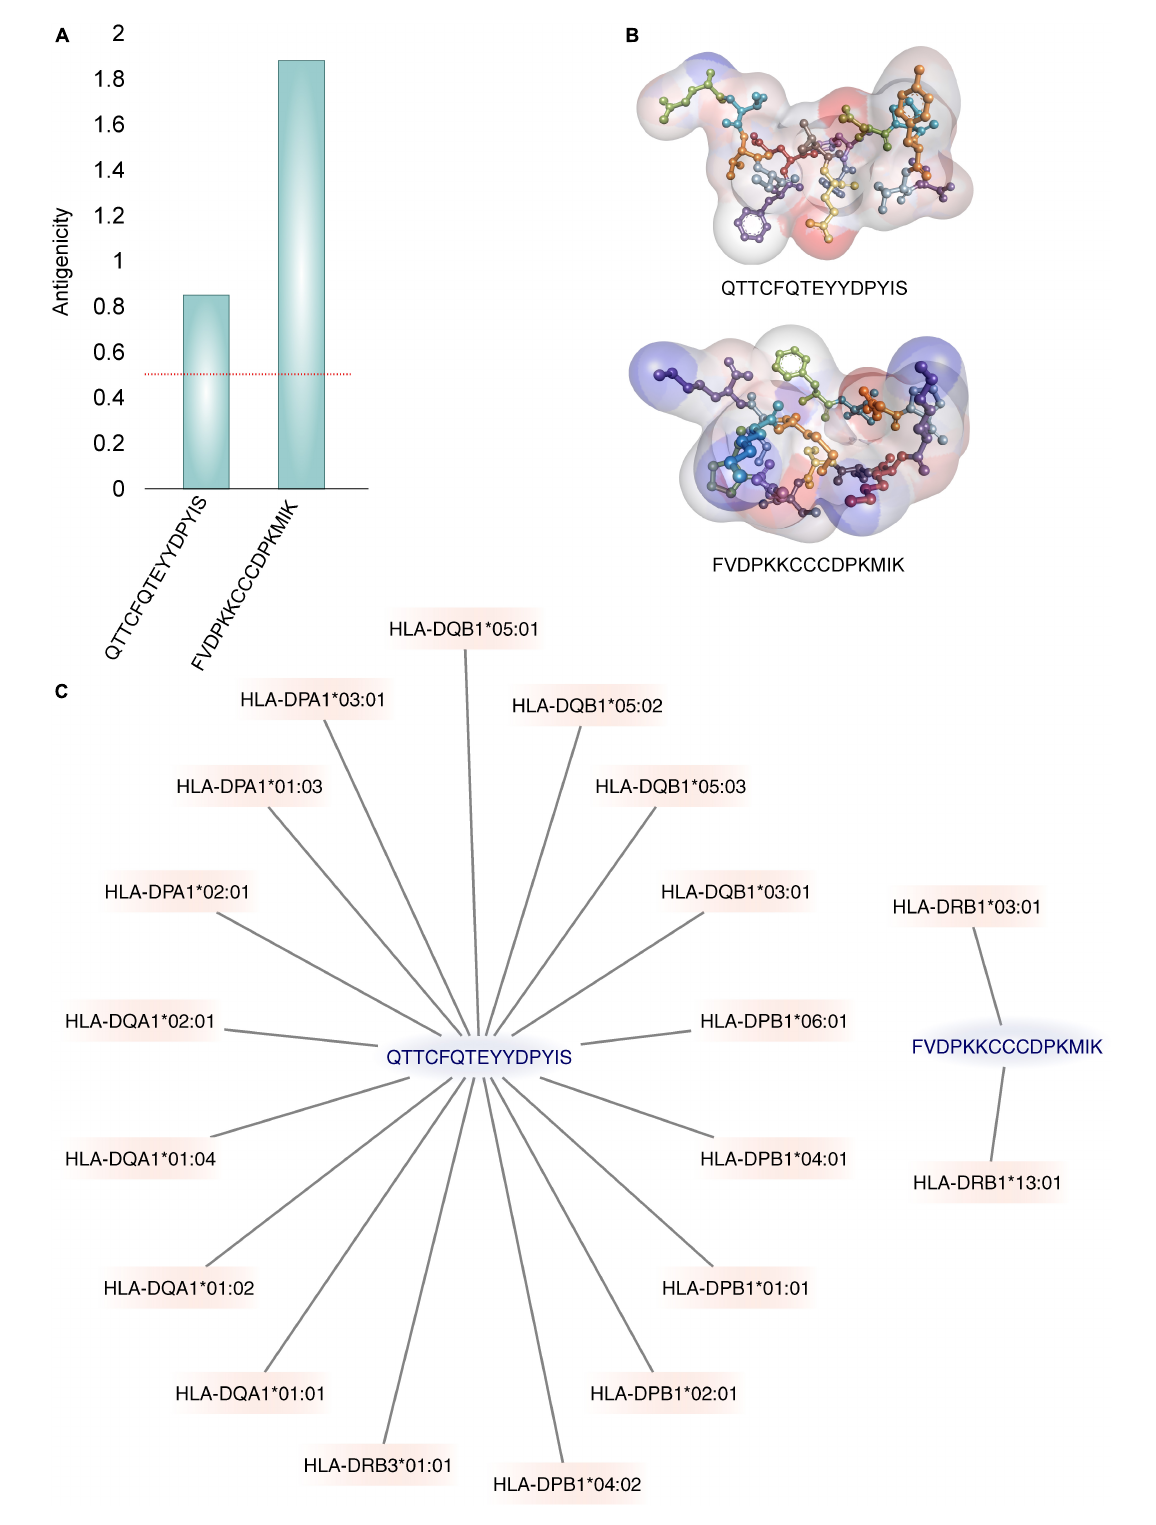
FIGURE3 The best two identified epitopes. (A) The Vaxijen server’s calculated antigenic potential (96) is displayed. A horizontal red line indicates the antigenicity threshold. (B) Illustrations of the 3D structures of epitopes. The residues are shown under a soft surface and are colored by atom charges. (C) Graphs are used to show how binding with MHC-II alleles is displayed. Only the alleles with binding IC50 values ≤ 500 nM are